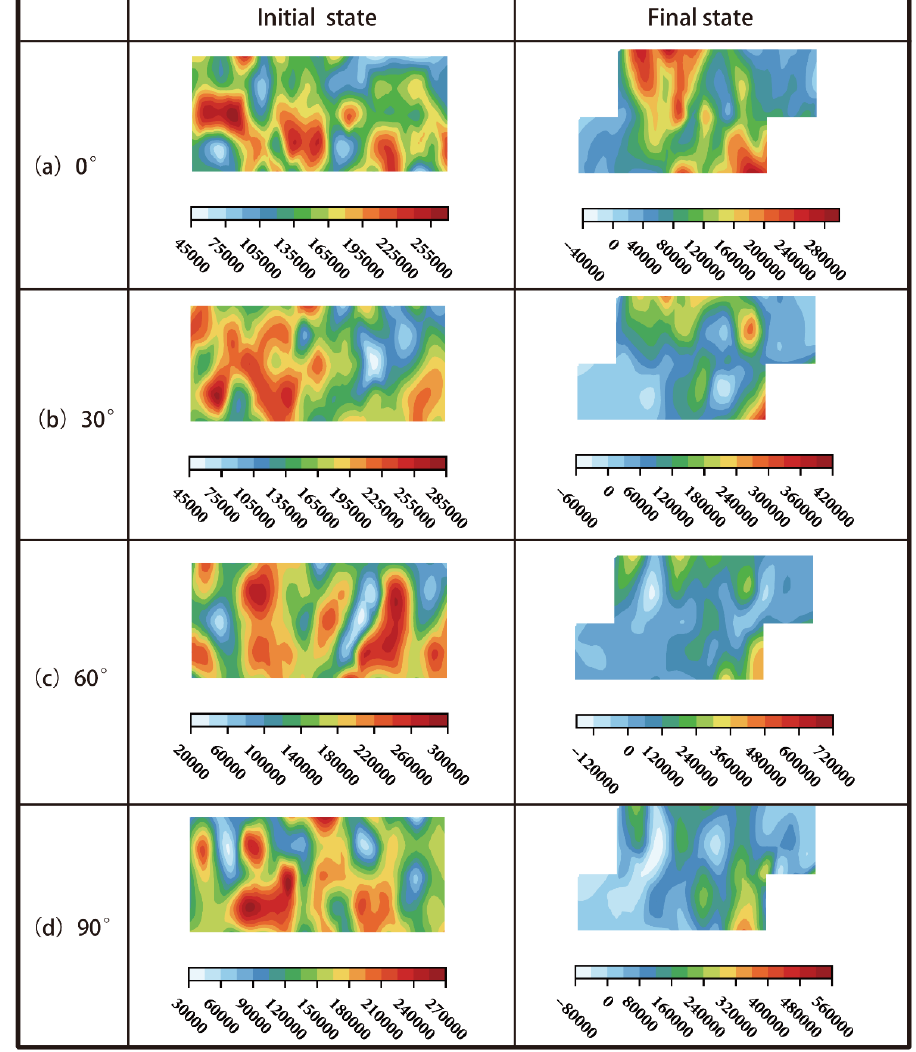
Figure 10. Contour plots of major principal stress: (a) fiber orientation = 0°, (b) fiber orientation = 30°, (c) fiber orientation = 60°, and (d) fiber orientation = 90°.